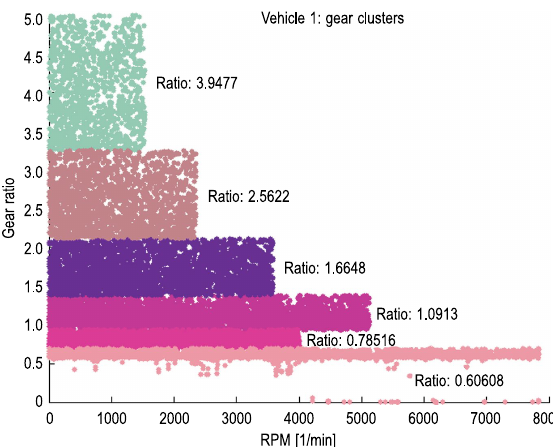
Fig. 9. Identified gear ratios using k -means using the cityblock clustering distance agree well with true gear